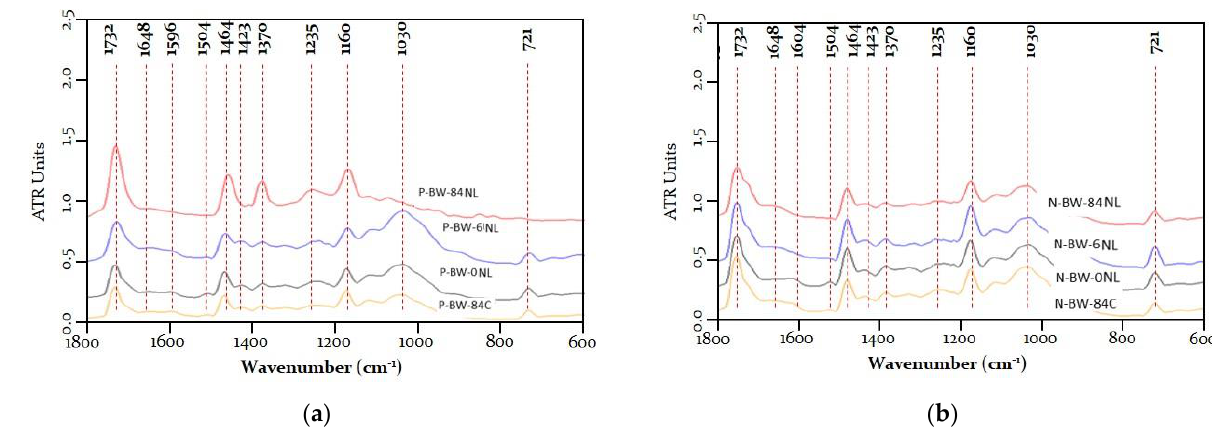
Figure 5. Comparative FTIR spectra (in the fingerprint region 2000 – 600 cm −1 ) of wood samples coated with beeswax before (0NL) and after simulated natural ageing (in the fingerprint region 2000 – 600 cm −1 ) for 6 (6NL) and 84 months (exposed to light 84NL and covered areas 84C): ( a ). European Maple wood (P); ( b ). European Walnut wood (N).